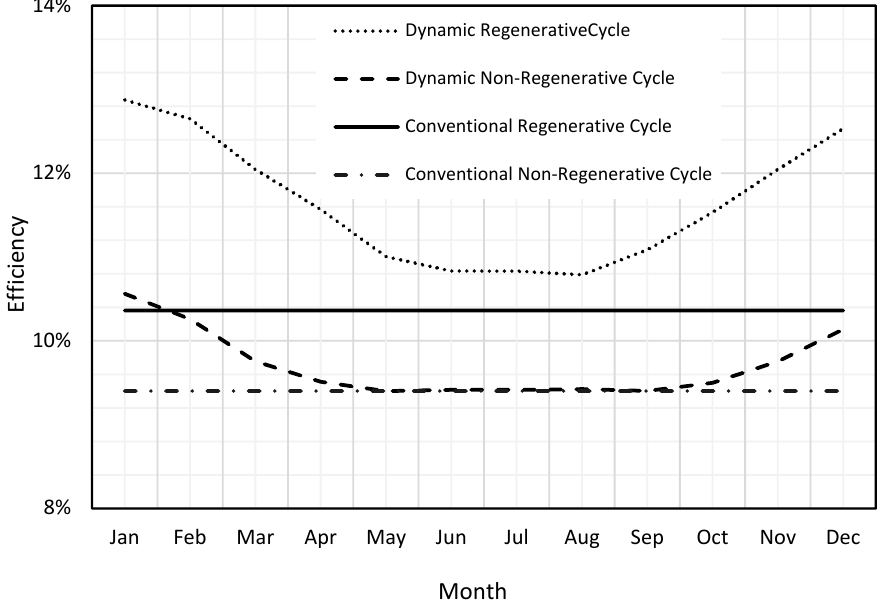
Figure 7. Annual variation in cycle efficiency for a heat source temperature of 100 °C under Beijing’s ambient conditions. Graph shows monthly averages.